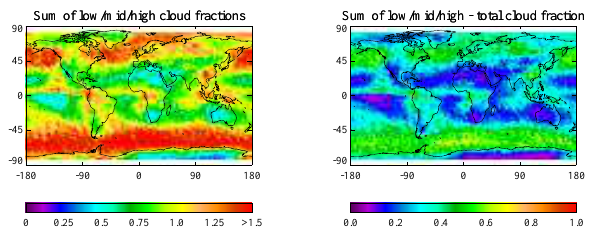
Fig. 12. Left: cloud cover calculated as the sum of the covers of low, mid-level and high clouds from the CALIPSO-GOCCP dataset in Fig. 11. Right: the difference between the field mapped on the left, and the total CALIPSO-GOCCP cloud cover from the bottom-left of Fig. 11.